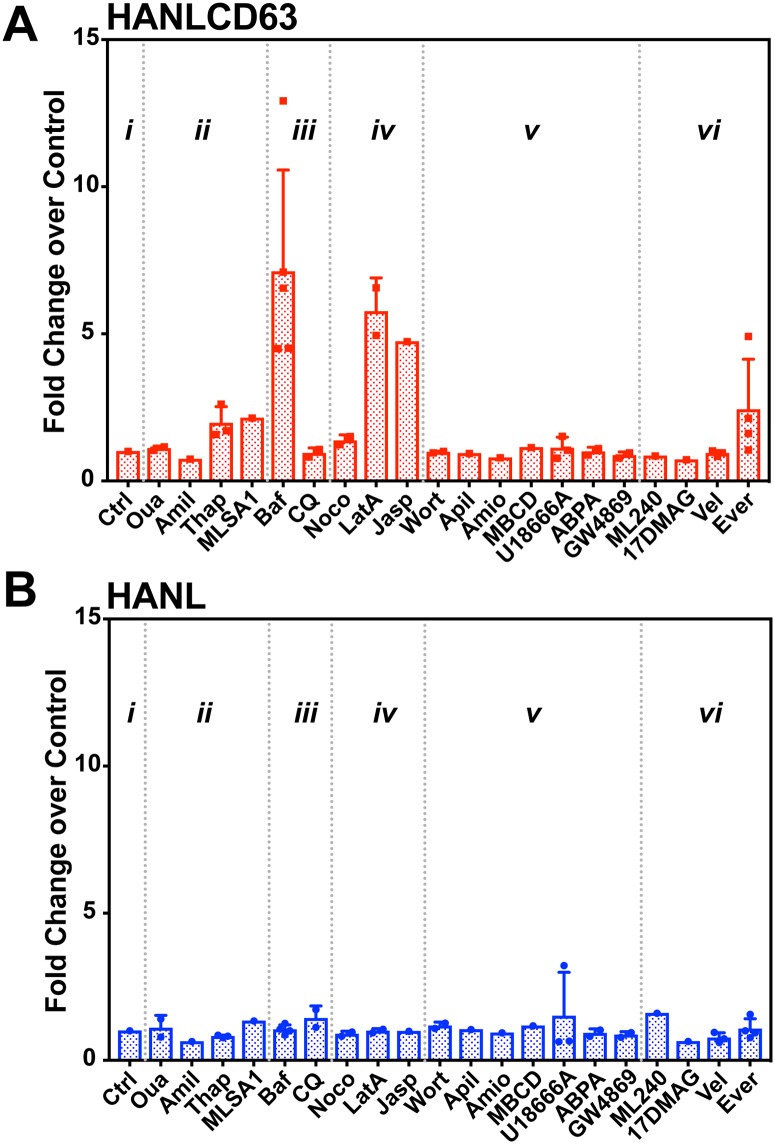
Screen for pathway perturbants.HANLCD63 (A) and HANL (B) expressing TRex293 cells were treated with indicated compounds during a 5h EV collection. Nluc activity in media is shown as fold change over that released by control cells (Ctrl). Compounds were used at the following concentrations: (i) Control—Ctrl (No drugs); (ii) Ion balance perturbants—Oua (175nM Ouabain); Amil (100nM Amiloride); Thap (1μM Thapsigargin); MLSA1 (50μM MLSA1); (iii) Lysosome perturbants—Baf (200nM Bafilomycin); CQ (50μM Chloroquine); (iv) Cytoskeleton perturbants—Noco (1uμg/ml Nocodazole); LatA (2μM LatrunculinA); Jasp (2μM Jasplakinolide); (v) Lipid perturbants—Wort (10μM Wortmannin); Apil (2μM Apilimod); Amio (10μM Amiodarone); MBCD (1mM MβCyclodextrin); U18666A (7μM U18666A); ABPA (2μM 1-aminodecylidene bis-phosphonic acid); GW4869 (17.3μM GW4869); (vi) Other perturbants—ML240 (5μM ML240); 17DMAG (2μM 17-DMAG); Vel (100nM Velcade); Ever (10μM Everolimus). Data were compared in two ways–First, using two-way ANOVA with Tukey’s multiple comparisons test to compare effects of each drug within each sample (HANL or HANLCD63). In HANLCD63 samples bafilomycin was significantly more effective in increasing EV release than control (p = 0.01) and CQ (p = 0.0002). Second, we also compared individual drug effects between HANL and HANLCD63 samples using multiple t-tests. This revealed that bafilomycin and latrunculin A significantly increases EV release in HANLCD63 (p values were 1.77e-8 for Baf and 6.37e-4 for LatA).